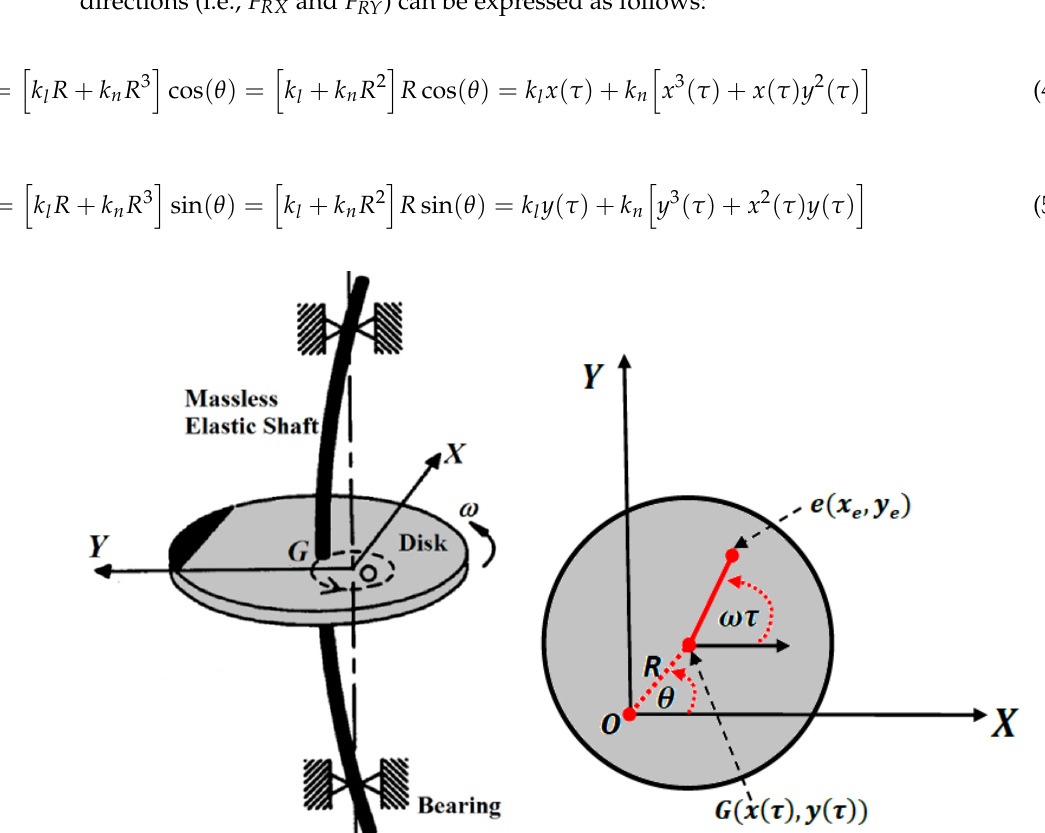
Figure 1. Uncontrolled Jeffcott rotor system.